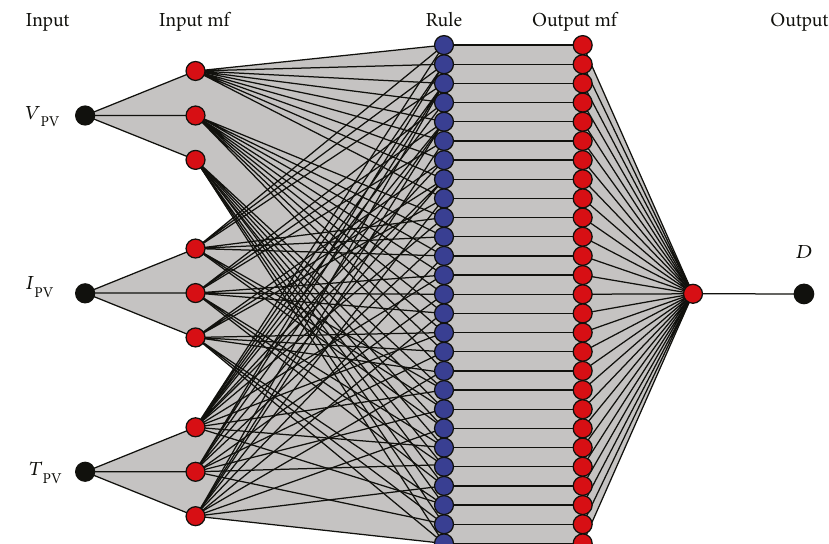
Figure 7: The proposed ANFIS model structure.